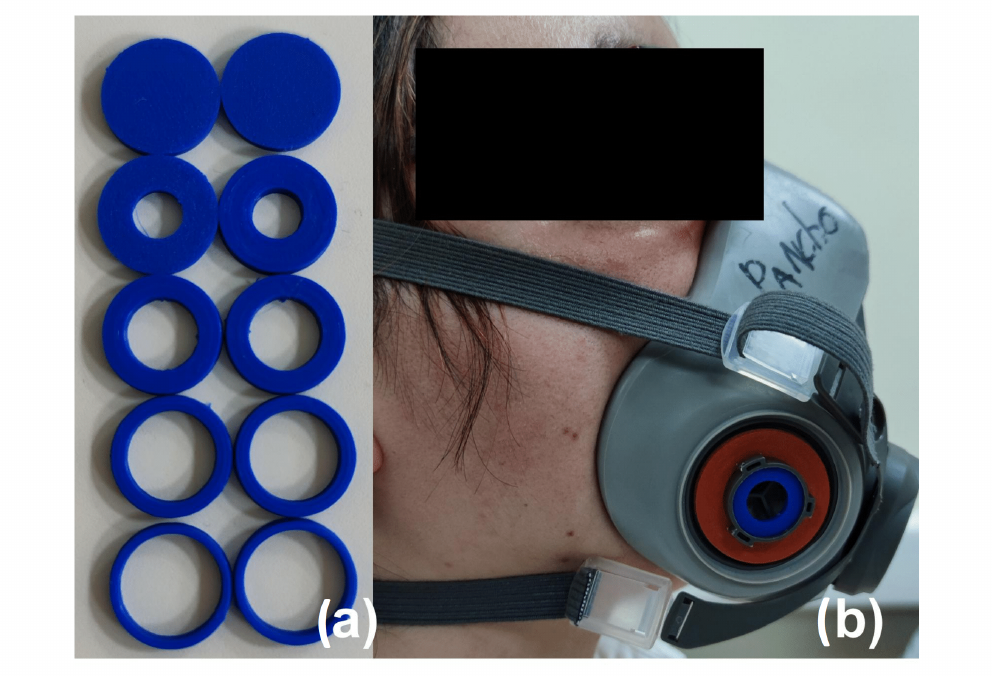
Figure 8. ( a ) Plastic pieces for simulating the filter clogging and ( b ) a volunteer using the respirator with the filter